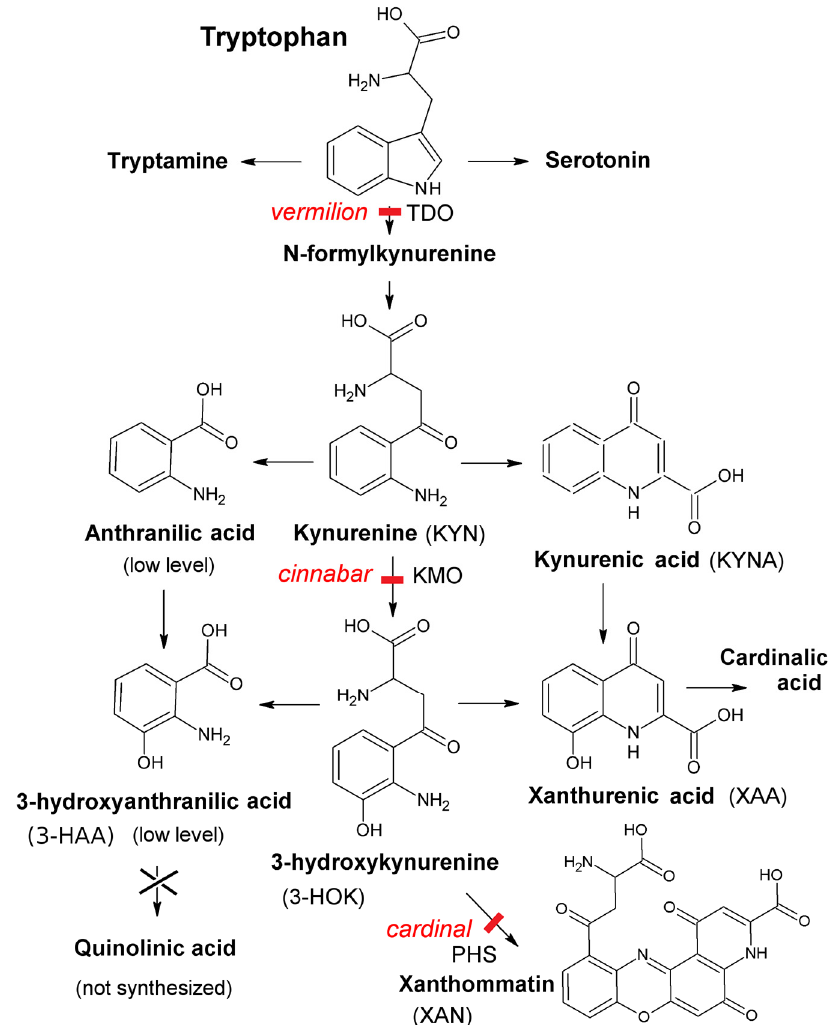
Figure 1. Kynurenine pathway in Drosophila . 3-HOK and 3-HAA possess antioxidant activity via inhibiting lipid peroxidation, while the antioxidant power of XAA is significantly less [17,18]. However, in high concentrations, 3-HOK undergoes non-enzymatic oxidative autodimerization, leading to overproduction of reactive oxygen species (ROS), such as hydrogen peroxide inducing apoptosis in neuronal cell culture [19,20]. Total antioxidant activity decreases in cd 1 heads compared to CS , while their lipid peroxidation also shows a tendency to decrease with age [16]. This reflects